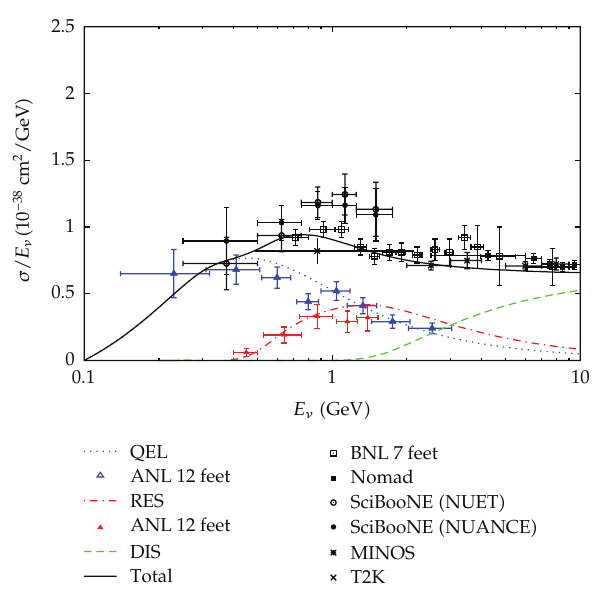
Figure 1: Breakdown of the inclusive CC muon neutrino cross section on free isoscalar target to QE, RES, and DIS contributions, as viewed by NuWro MC event